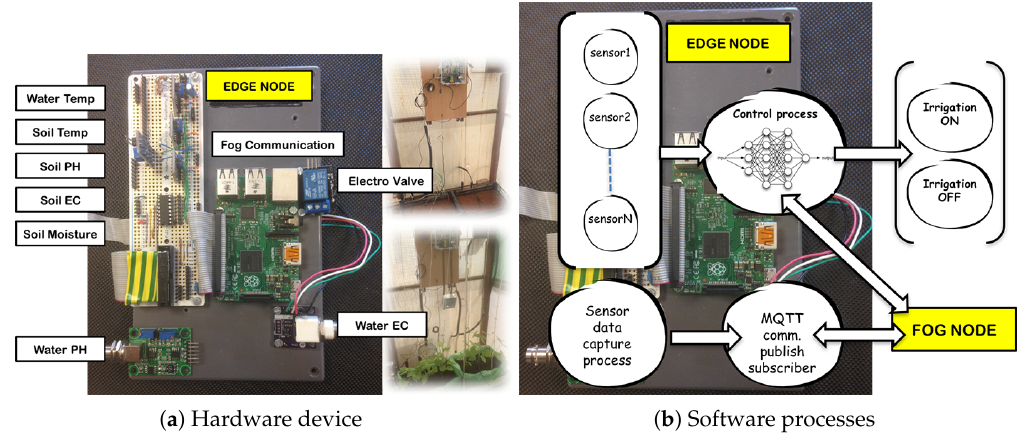
Figure 8. Hardware and software deployed on experimental greenhouse edge